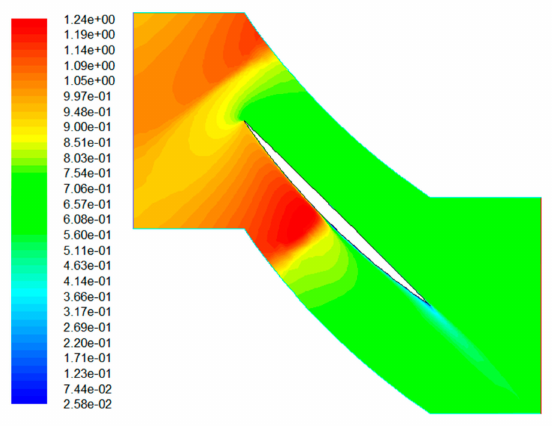
Figure 26. Contours of the Mach number for the current blade